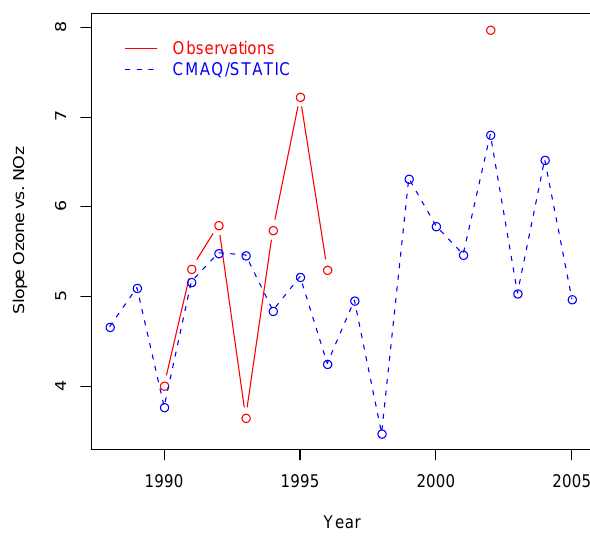
Fig. 9. Time series of the O 3 vs. NO z slope for observations and CMAQ/STATIC simulations. For a given year, the slope was esti- mated from a least-squares regression of O 3 vs. NO z concentrations during May–September, considering only values during the photo- chemically active time period between 10:00 and 17:00 local time. Furthermore, only hours when the NO x /NO z ratio was less than 0.3 and NO z was less than 8ppb were included in the analysis to screen out air masses influenced by fresh